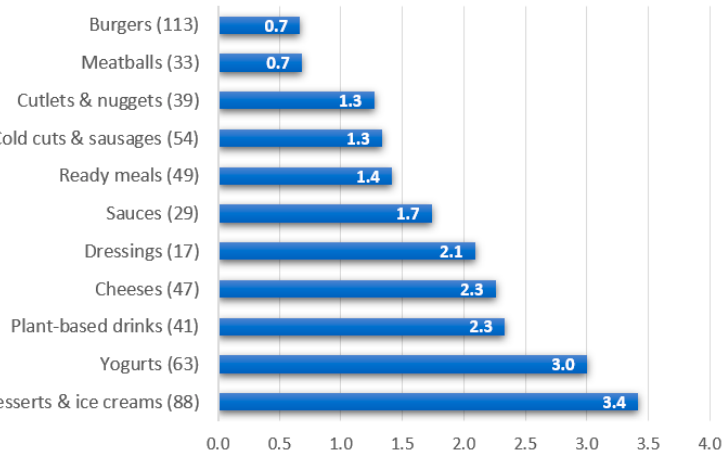
Figure 5. Prevalence of additive-containing products in the categories of processed plant-based products. The total number of analyzed products per category is reported in brackets.